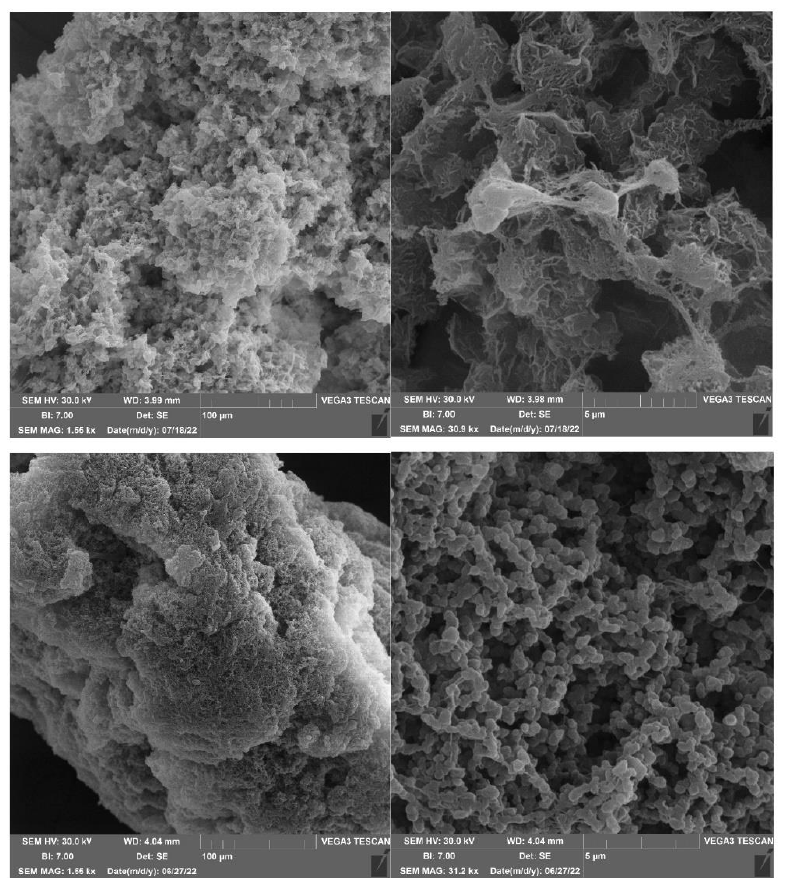
Figure 5. SEM images of the surface morphology of UHMWPE powders obtained with catalytic system (L2) 2 TiCl 2 /MMAO12 (top, entry 13, Tables 1 and 2) and (L1) 2 TiCl 2 / Et 2 AlCl+ Bu 2 Mg